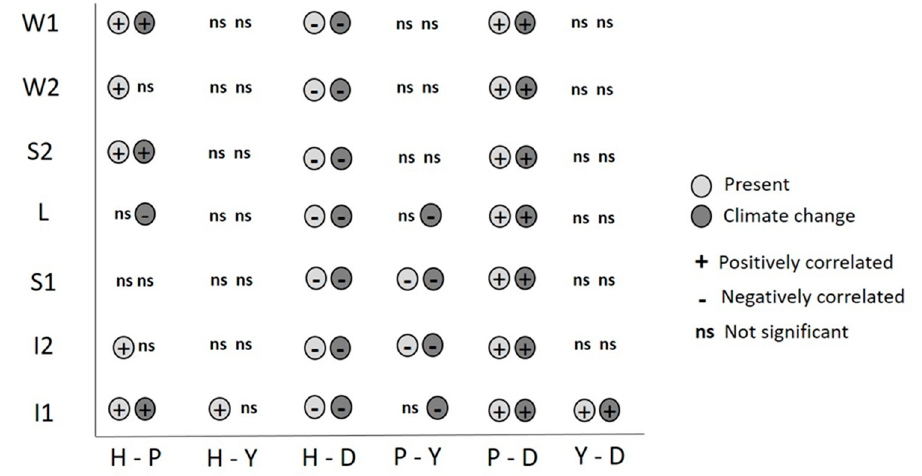
Figure 4. Pairwise correlation coefficients ( ρ ) computed between factors (the hatching rate (H), probability that the water balance is positive (P), mean number of resting eggs produced per female (Y) and deterioration rate (D) for each clone (W1, W2, S2, L, S1, I2, I1) in present and climate change conditions (Table S3).